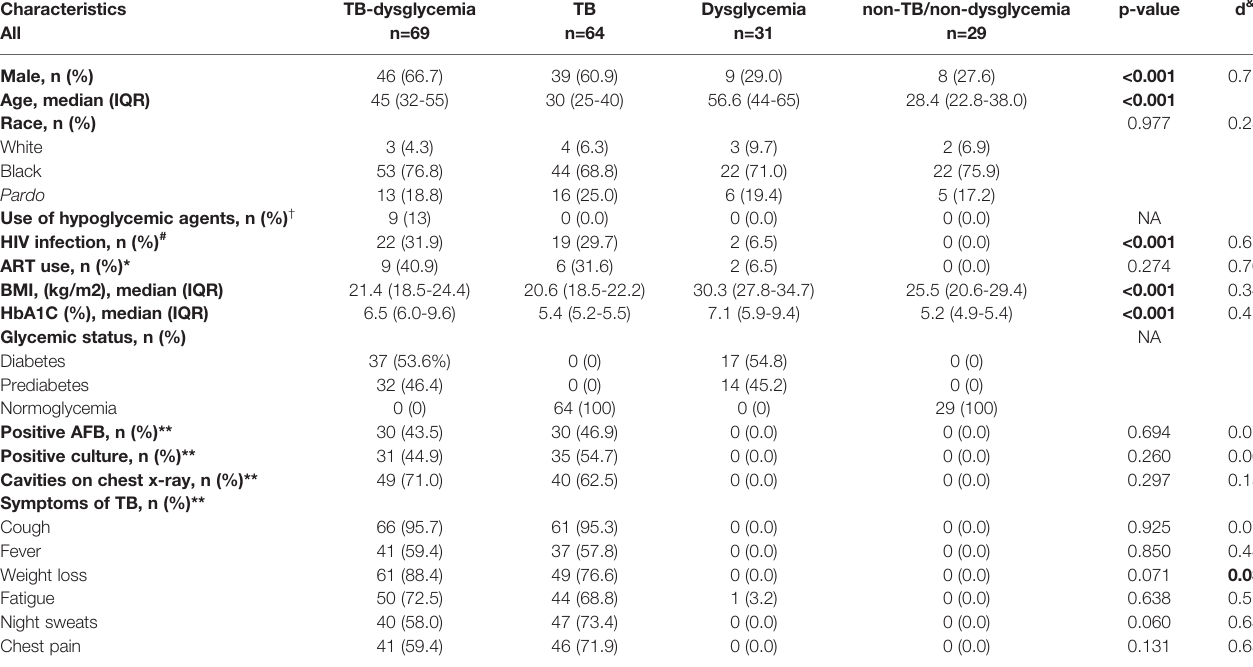
TABLE 1 | Characteristics of the study